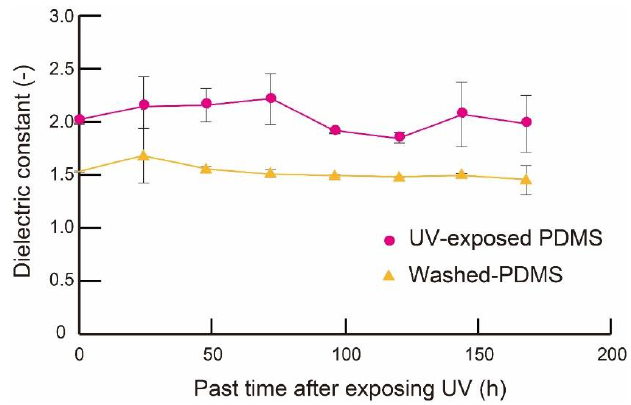
Figure 9. Dielectric constant of a 250-μm thick PDMS layer after UV treatment with or without washing (n = 20).